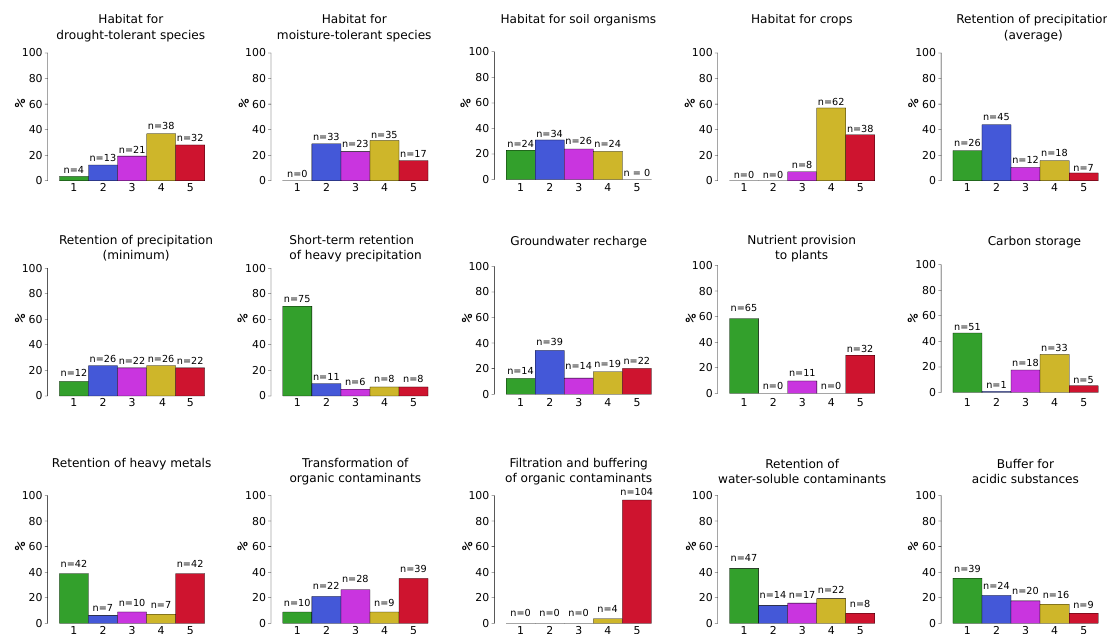
Figure 4. Barplots representing the distribution of the soil function fulfillment levels of the locations of the 108 soil profiles assessed with the SEPP tool.